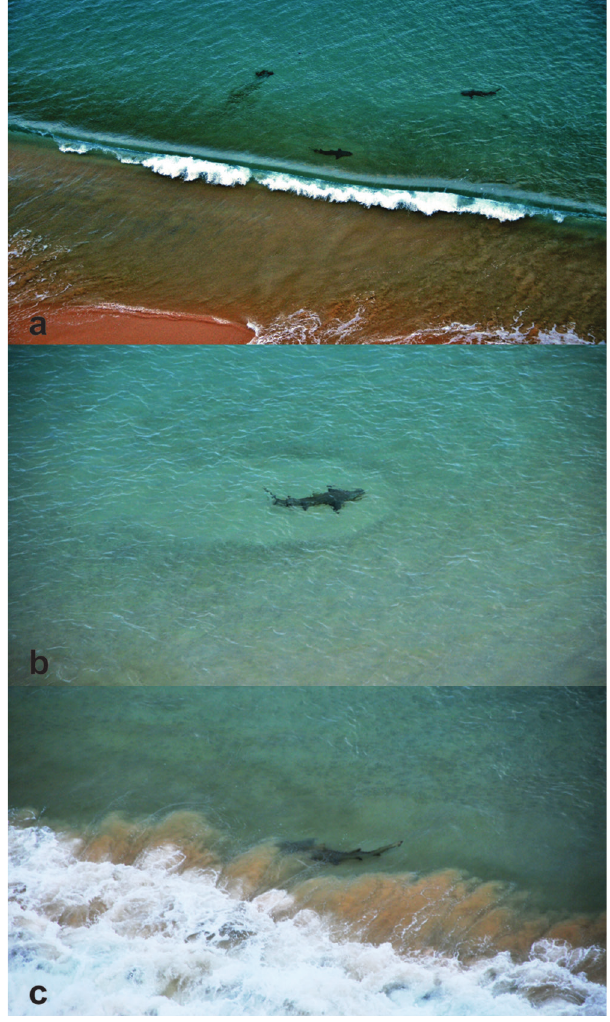
Fig. 4. a. Two Negaprion brevirostris (TL > 2 m) patrolling the shoreline near the surf zone of site 03 in January 2012. b. Lemon shark surrounded by a school of sardines displaying “vacuole” behaviour ( sensu Magurran, Pitcher 1987). c. The same shark seconds before striking the school of sardines hidden by sand suspension (Photographs by José Carlos